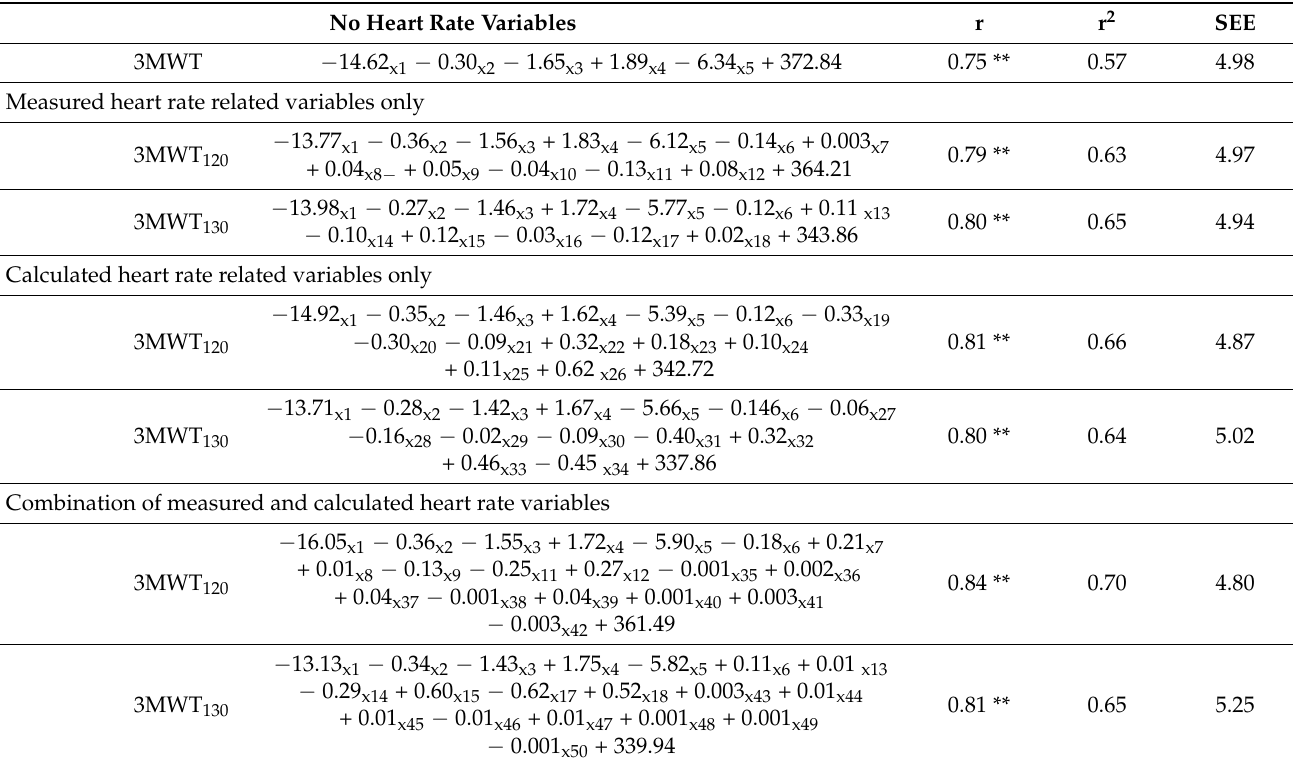
Table 5. Maximal oxygen consumption prediction